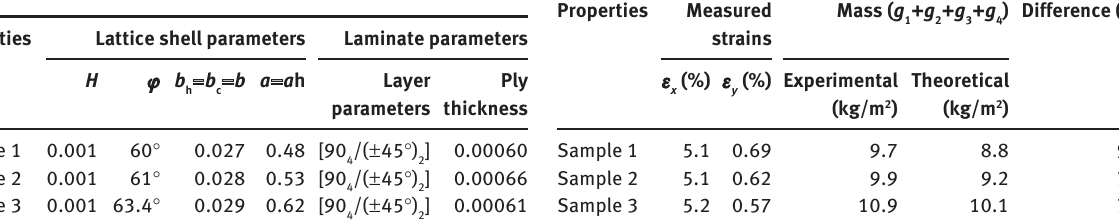
Table 2 Parameters of the considered samples [m].